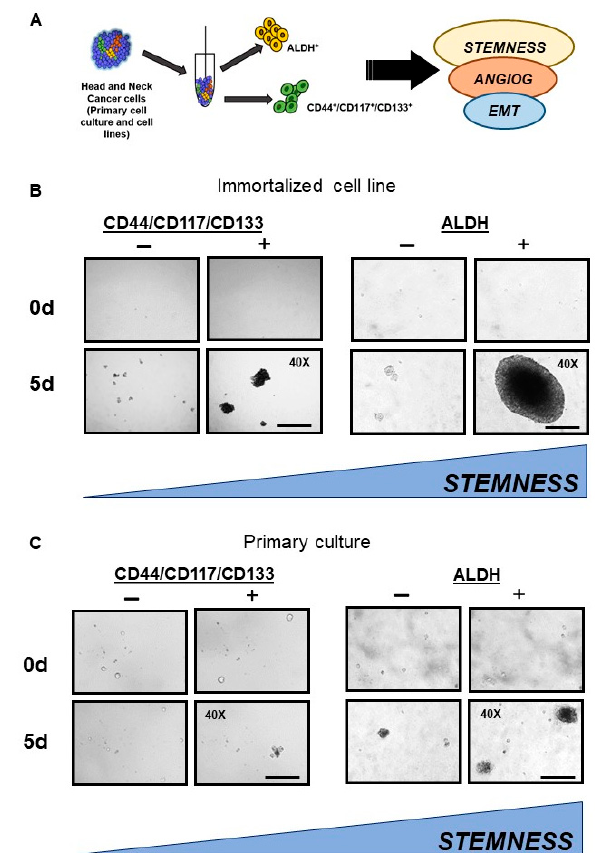
Figure 4. Isolation of distinctive cancer stem cell behavior. ( A ) Schematic illustration of FACS isolation of the two populations of stem cells from head and neck cancer cell lines and primary culture. DEAB negative was the basis for gating ALDH + cells. Meanwhile, the ALDH − and CD44 − CD117 − CD133 − cells were also sorted. ( B ) Isolated CDs + and ALDH + cells cultivated in ultra-low attachment conditions showed an increased number of spheroids compared with the negative control groups. Moreover, ALDH+ cells enhanced stemness potential by a different diameter in the head and neck cancer cell line (FaDu ALDH + and HEP2 CDs + cells). ( C ) ALDH + cells show an increased number of spheroids compared to those arising from the primary cultures of head and neck squamous cell carcinoma.